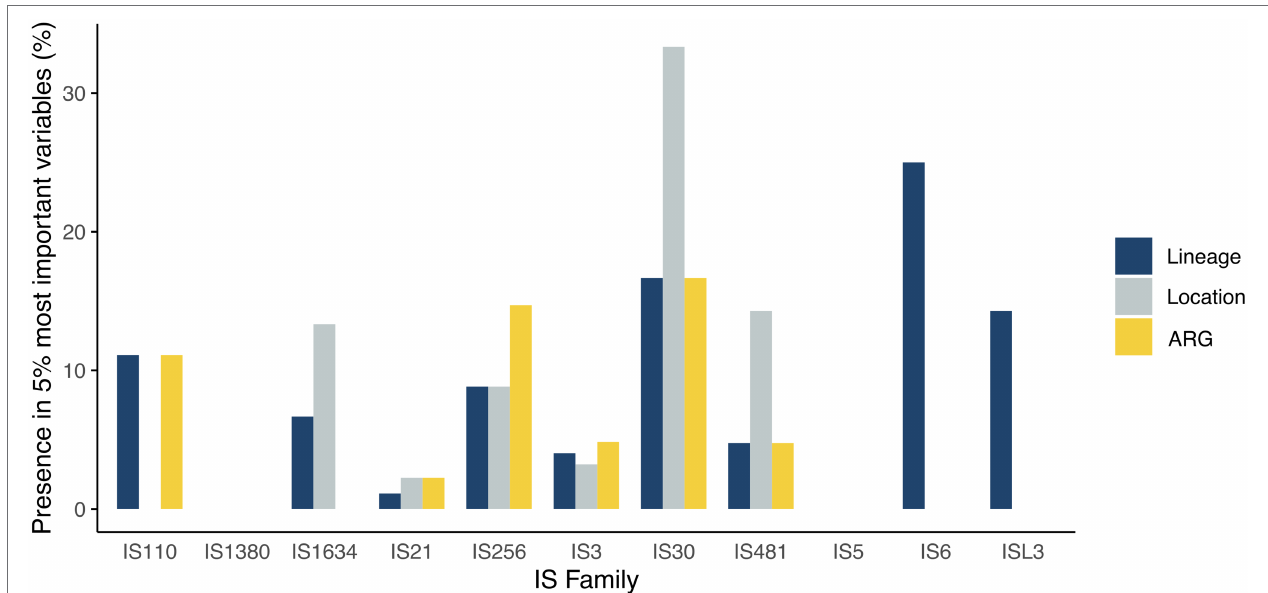
FIGURE 2 | The importance of IS Families in each epidemiological variable. Presence of 5% of the most important functionally annotated insertion sequences for Random Forest (RF) in each epidemiological variable evaluated. All RFs consisted of 501 trees each and were calculated using the random forest 4.6-14 package (Breiman, 2001; default parameters) in version R 4.1.0 (The R Project for Statistical Computing; http://www.r-project.org). For RFs validation, a k -Fold Cross Validation test ( k -fold = 100), and a Kappa concordance test were carried out (for lineage classification, k = 0.963, value of p < 0.0001; for Location classification, k = 0.597, value of p < 0.0001; for ARG classification, k = 0.786, value of p < 0.0001). Finally, the importance of each variable was based on the mean decrease Gini index respecting the pathline described by Dutilh et al.